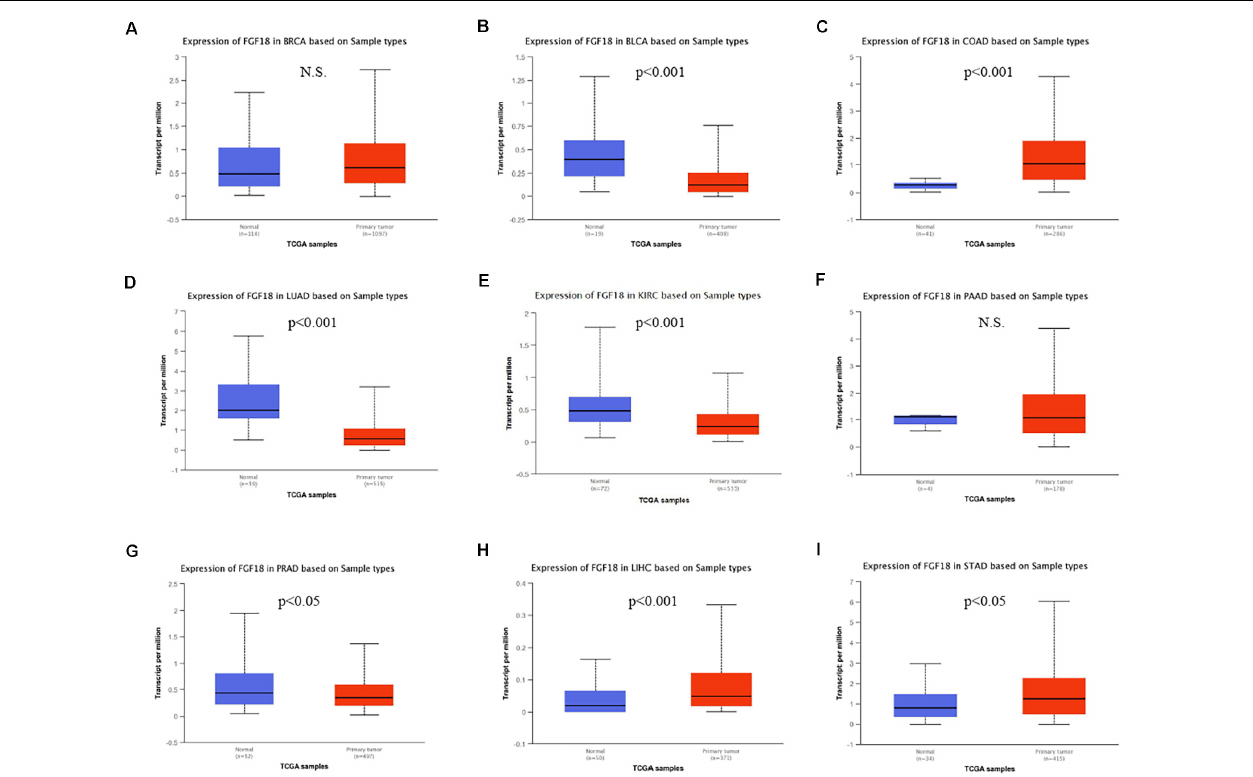
FIGURE 1 | Differential expression of FGF18 in several cancer types based on the TCGA database. Expression levels of FGF18 between normal and primary tumor samples from TCGA were investigated, which included (A) breast invasive carcinoma (BRCA), (B) bladder urothelial carcinoma (BLCA), (C) colon adenocarcinoma (COAD), (D) lung adenocarcinoma (LUAD), (E) kidney renal clear cell carcinoma (KIRC), (F) pancreatic adenocarcinoma (PAAD), (G) prostate adenocarcinoma (PRAD), (H) liver hepatocellular carcinoma (LIHC), and (I) stomach adenocarcinoma (STAD) (N.S., No statistical significance).